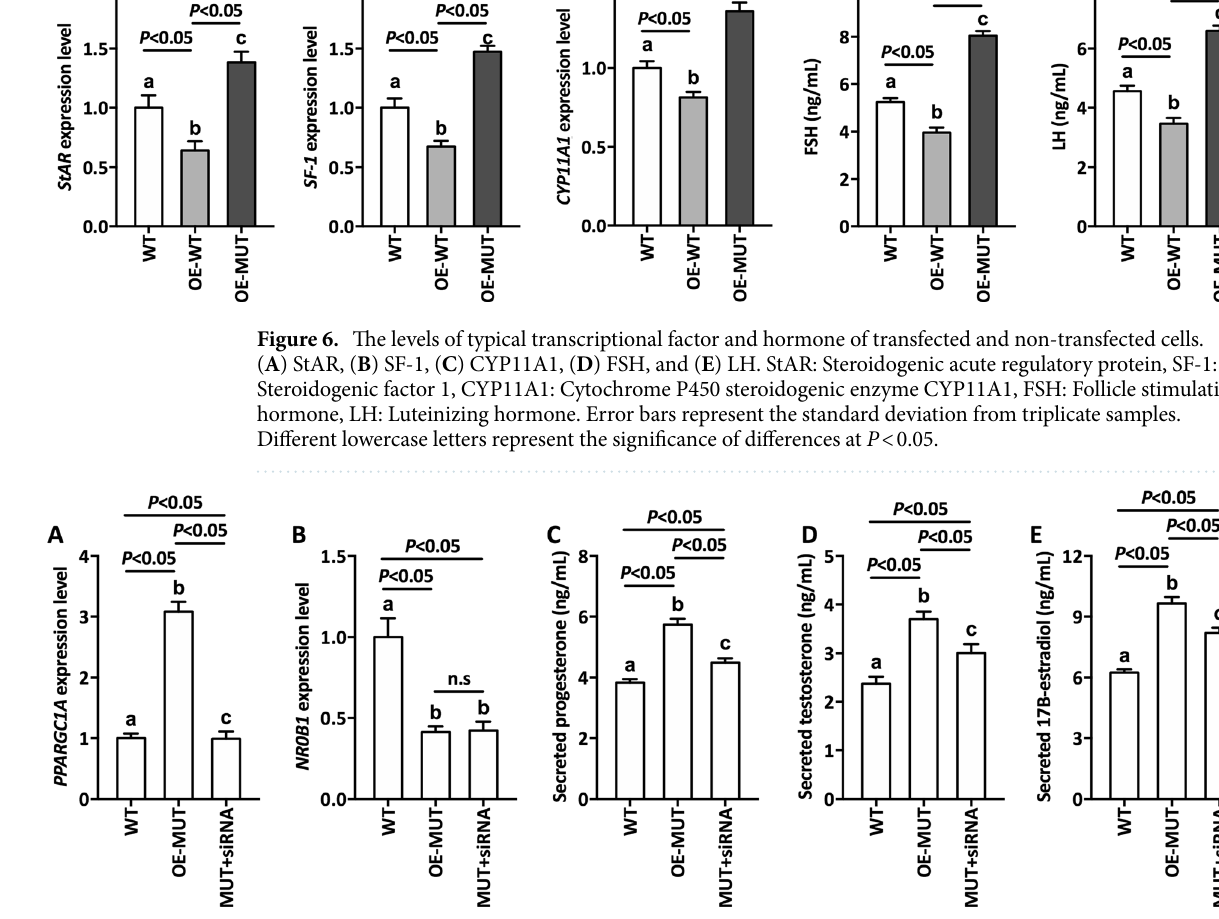
Figure 7. Biochemical characteristics of cells treated with siRNA of PPARGC1A. ( A ) Relative expression level of PPARGC1A and ( B ) NR0B1 . ( C ) Secreted progesterone level, ( D ) secreted testosterone level, and ( E ) secreted 17B-estradiol. WT: Wild-type cells, OE-WT: Cells overexpressing normal NR0B1 , MUT-siRNA: Cells overexpressing variant NR0B1 and siRNA of PPARGC1A. Error bars represent the standard deviation from triplicate samples. Different lowercase letters represent the significance of differences at P <